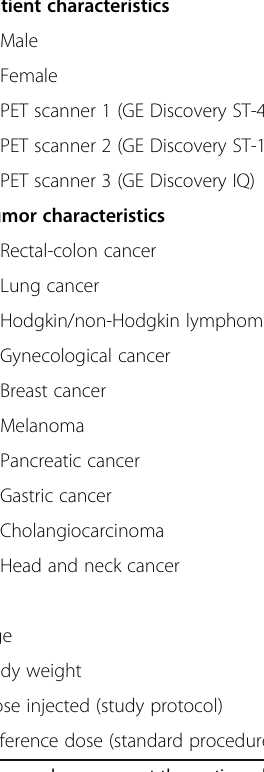
Table 1 Population characteristics Patient